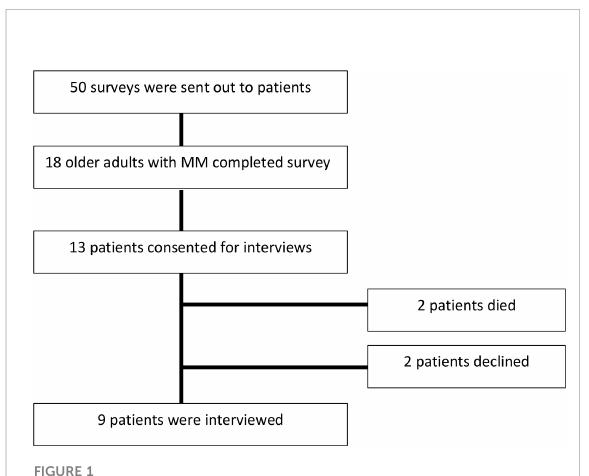
FIGURE 1 Flow chart showing those eligible patients vs participating patients.